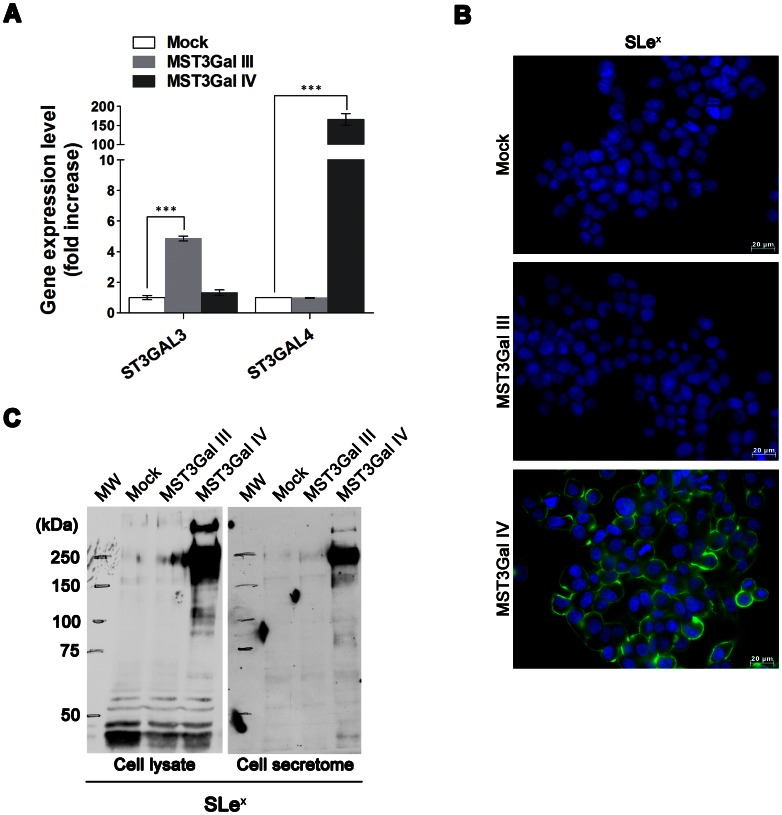
Induction of SLex expression by ST3Gal IV transfection in gastric carcinoma cells.
A – Relative quantification of ST3GAL3 and ST3GAL4 mRNA expression in MOCK, MST3Gal III and MST3Gal IV transfected cells showing a significant overexpression of ST3GAL3 gene in MST3Gal III cells and ST3GAL4 in MST3Gal IV cells when comparing gene expression levels in mock cells; ***p<0.001 Mock versus MST3Gal III for ST3GAL3 gene and ***p<0.001 MST3Gal IV versus Mock for ST3GAL4 gene. Results are presented as means ± SD. B – Immunofluorescence detection of SLex expression in Mock, MST3Gal III and MST3Gal IV cells evidencing the presence of SLex in MST3Gal IV (magnification 200x); C – Western blot detection of SLeX in proteins from total cell lysate and secreted proteins from Mock, MST3Gal III and MST3Gal IV cells. SLex expression was observed on cell lysates and secretome from ST3GAL4 transfected cells (MST3Gal IV).